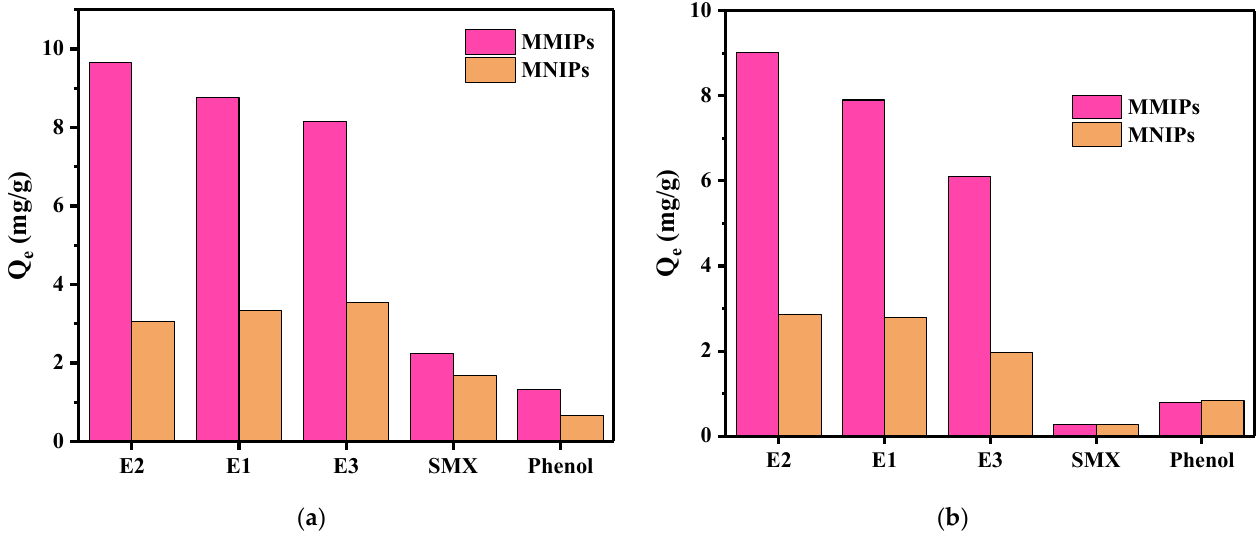
Figure 7. Adsorption capacity of MMIPs and MNIPs for E2 and other four compounds in: ( a ) single system, and ( b ) multiple system. Conditions: [E2 or other compounds] 0 = 5 mg/L, [MMIPs or MNIPs] 0 = 0.5 g/L, T = 30 °C, and pH = 6.0.